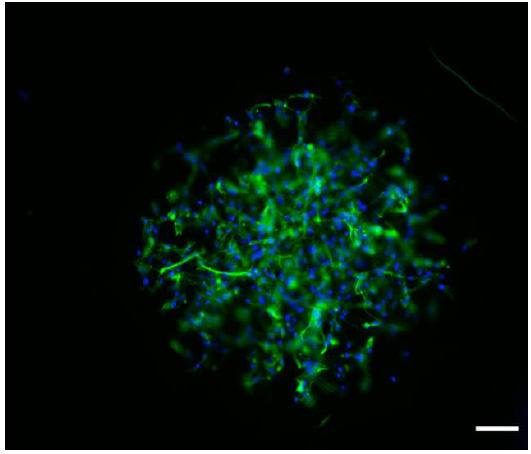
Figure 7. Interaction of astrocytes with fibers prepared with PCL 394 /PEO 148 - b -PCL 13 blend and observed by epifluorescence microscopy. Scale bar is 150 µm. Green marks correspond GFAP positive cells (glioblasts/astrocytes); and blue marks to cell nucleus (DAPI).